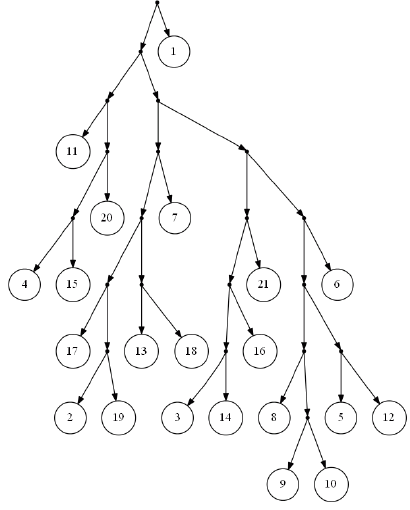
Figure 2. Output of FastTree for a dense triplet set of the yeast, Cryptococcus gattii ,